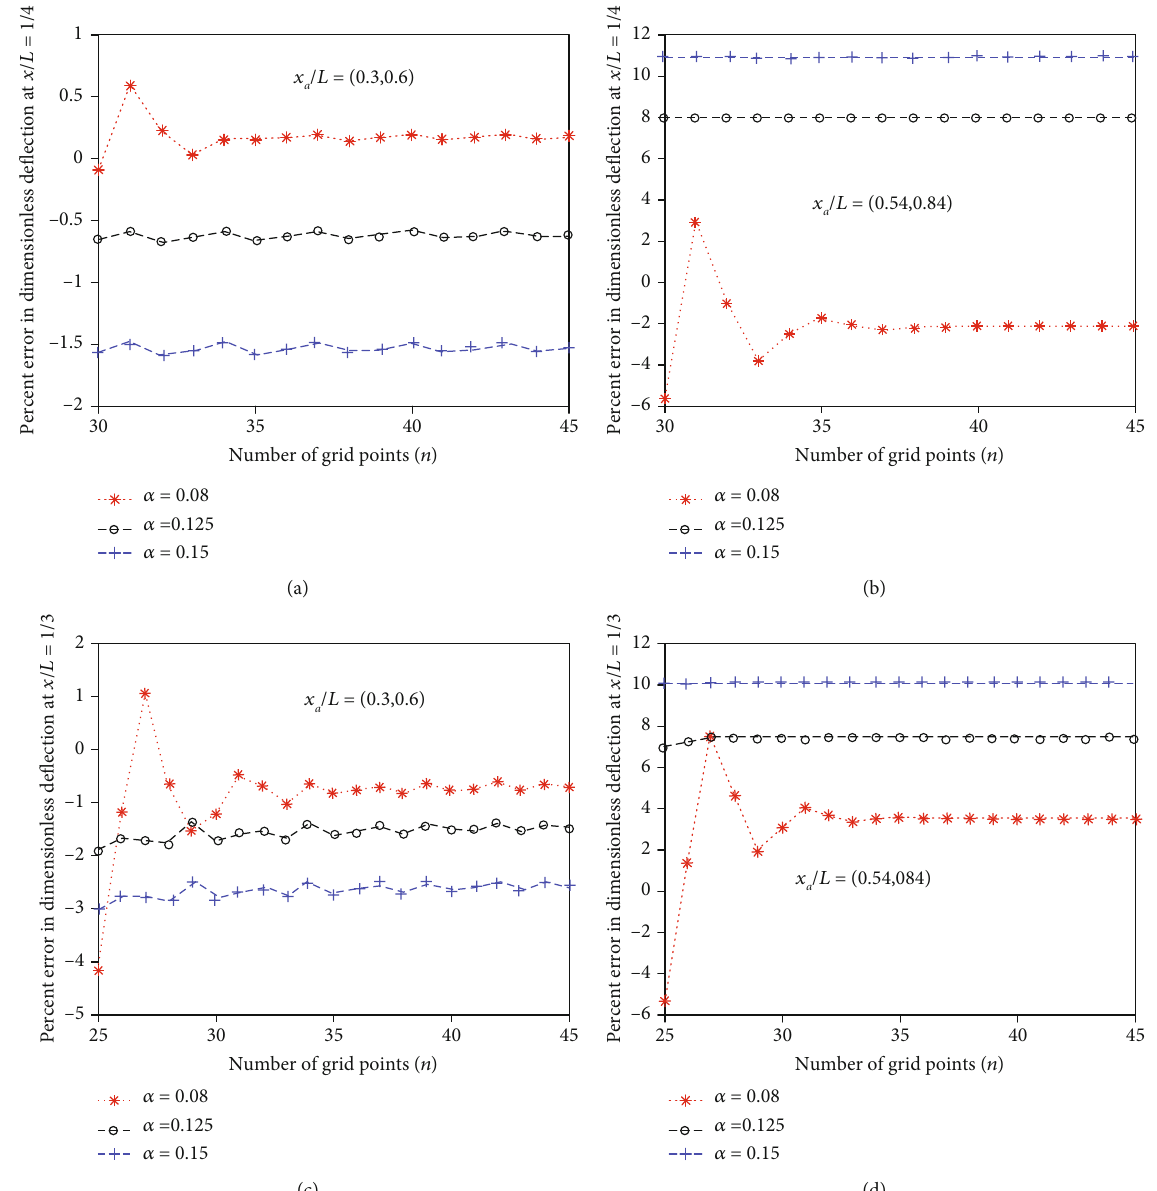
Figure 4: Convergence and accuracy of the dimensionless de fl ection of a simply supported beam under a constant voltage V actuator at x / L = 1/4 for x a / L = ð 0 : 3,0 : 6 Þ (a), x a / L = ð 0 : 54,0 : 84 Þ (b), and at x / L = 1/3 for x a / L = ð 0 : 3,0 : 6 Þ (c), x a / L ð 0 : 54,0 : 84 Þ (d) for di ff erent values of α